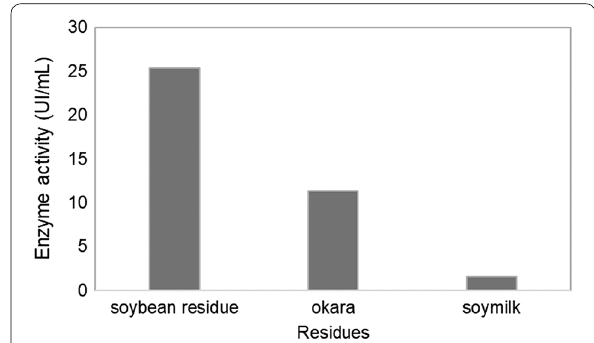
Fig. 1 β‑galactosidase activity in different soybean products, after 7 days of submerse fermentation at 120 rpm and 28 °C Table 2 Results of β-galactosidase activity (U/mL), according to the 2 3 factorial design with centered face and three repetitions at the central point central